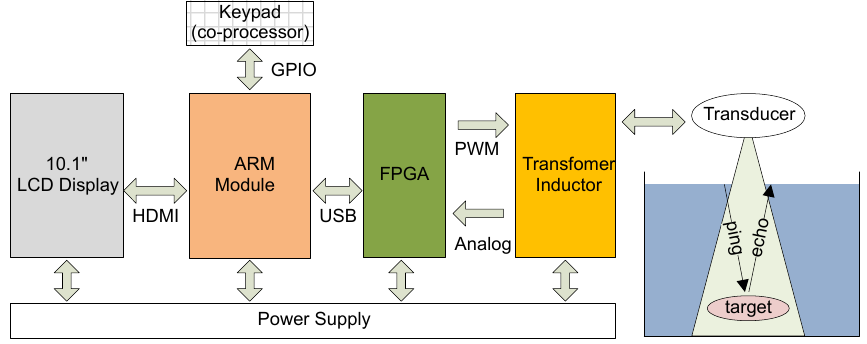
Figure 1. Architecture of the SFBE device.